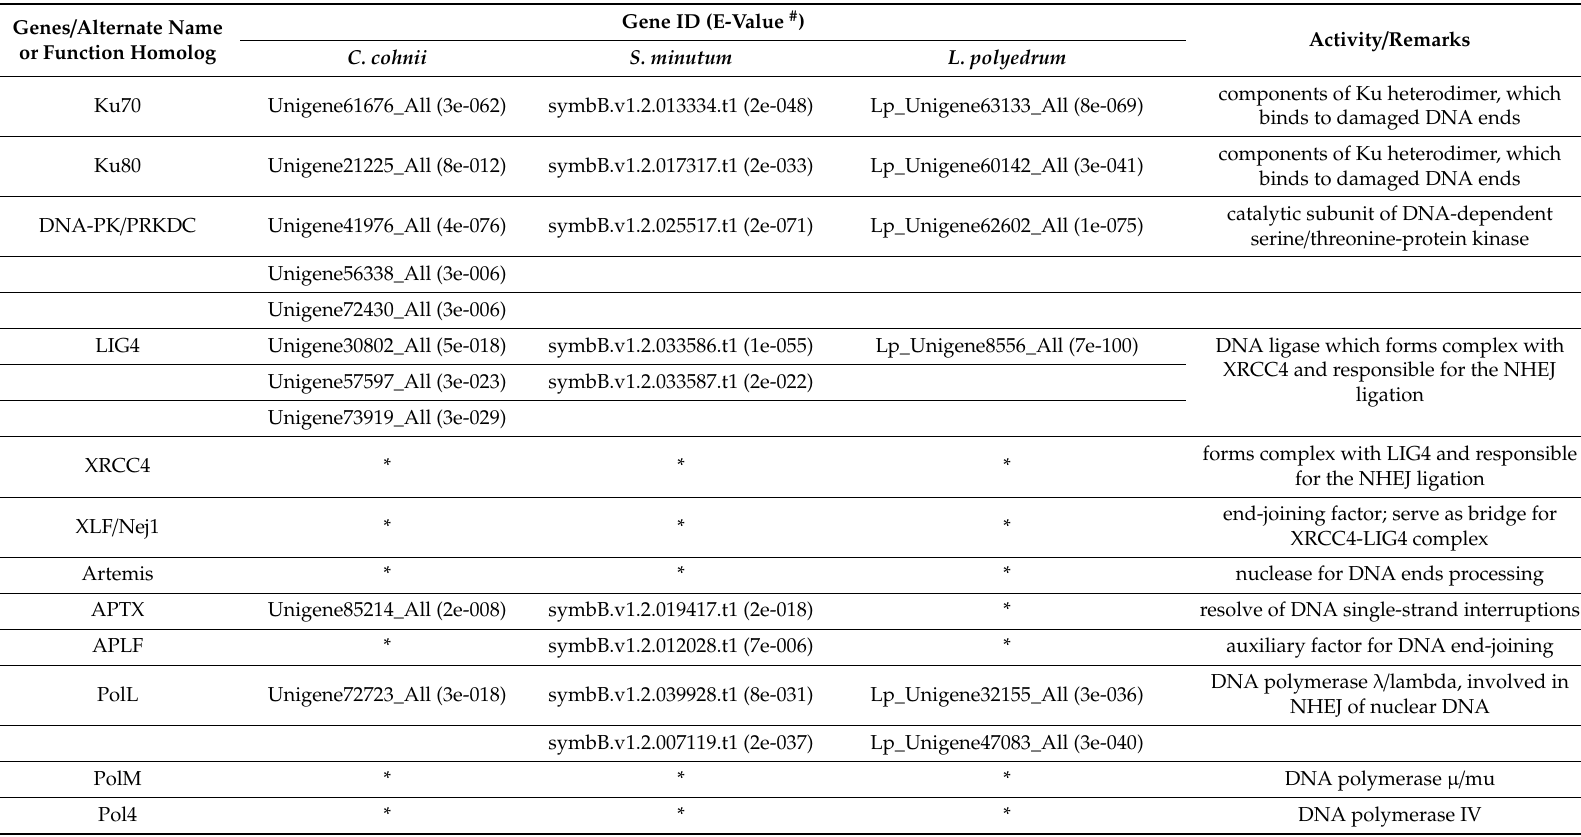
Table 6. Predicted dinoflagellate orthologues in non-homologous end